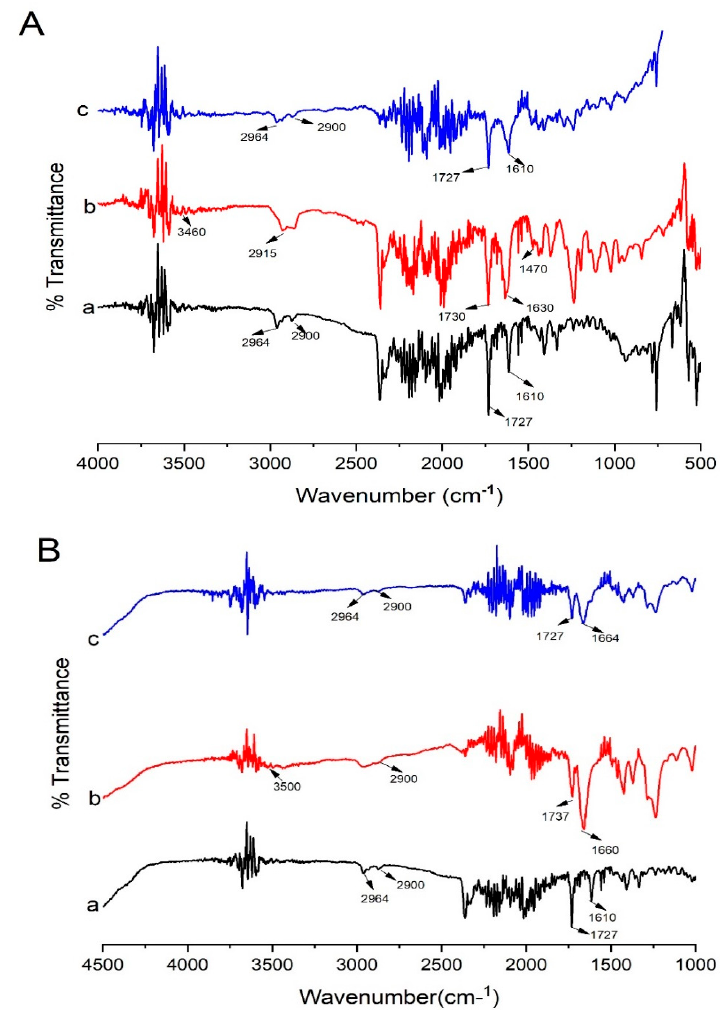
Figure 10. FTIR data of ( A ) Soluplus ® -based solid dispersion formulation: (a) pure Irbesartan, (b) Soluplus ® , (c) binary system of drug and Soluplus ® at ratio 1:1 [S 1 ]. ( B ) Kollidon ® VA 64-based solid dispersion formulation: (a) pure Irbesartan, (b) Kollidon ® VA 64, (c) binary solid dispersion of drug and Kollidon ® VA 64 at ratio 1:4 [K 4 ]. Note: Background noise may be present along with signals of compounds in FTIR